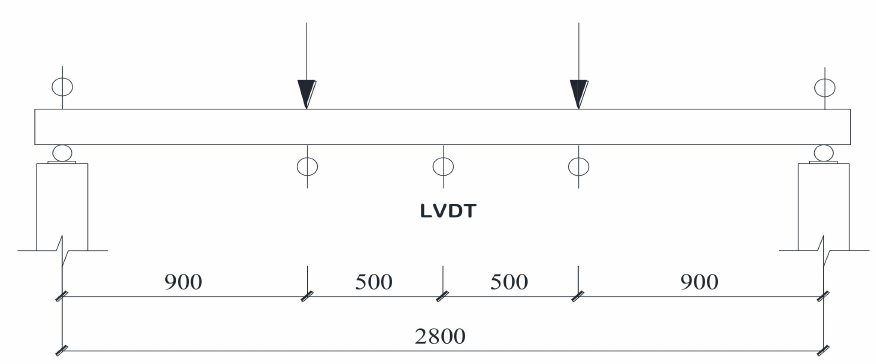
Figure 5. Schematic diagrams of